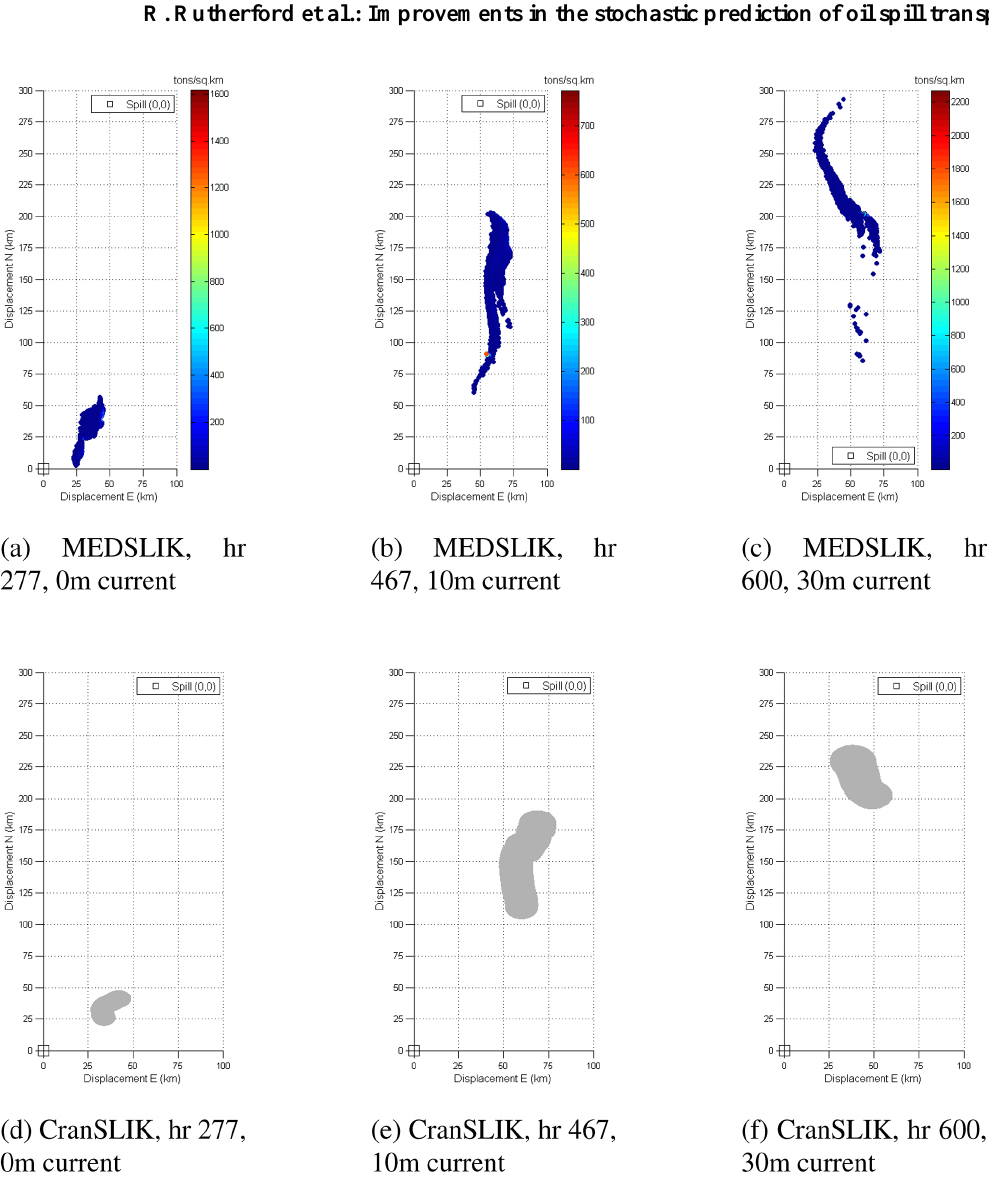
Figure 12. MEDSLIK and CranSLIK “bad” (minimum % oil captured) slick forecasts for the Lebanon case, using the current at different depths as the advective current. Note that CranSLIK does not predict oil